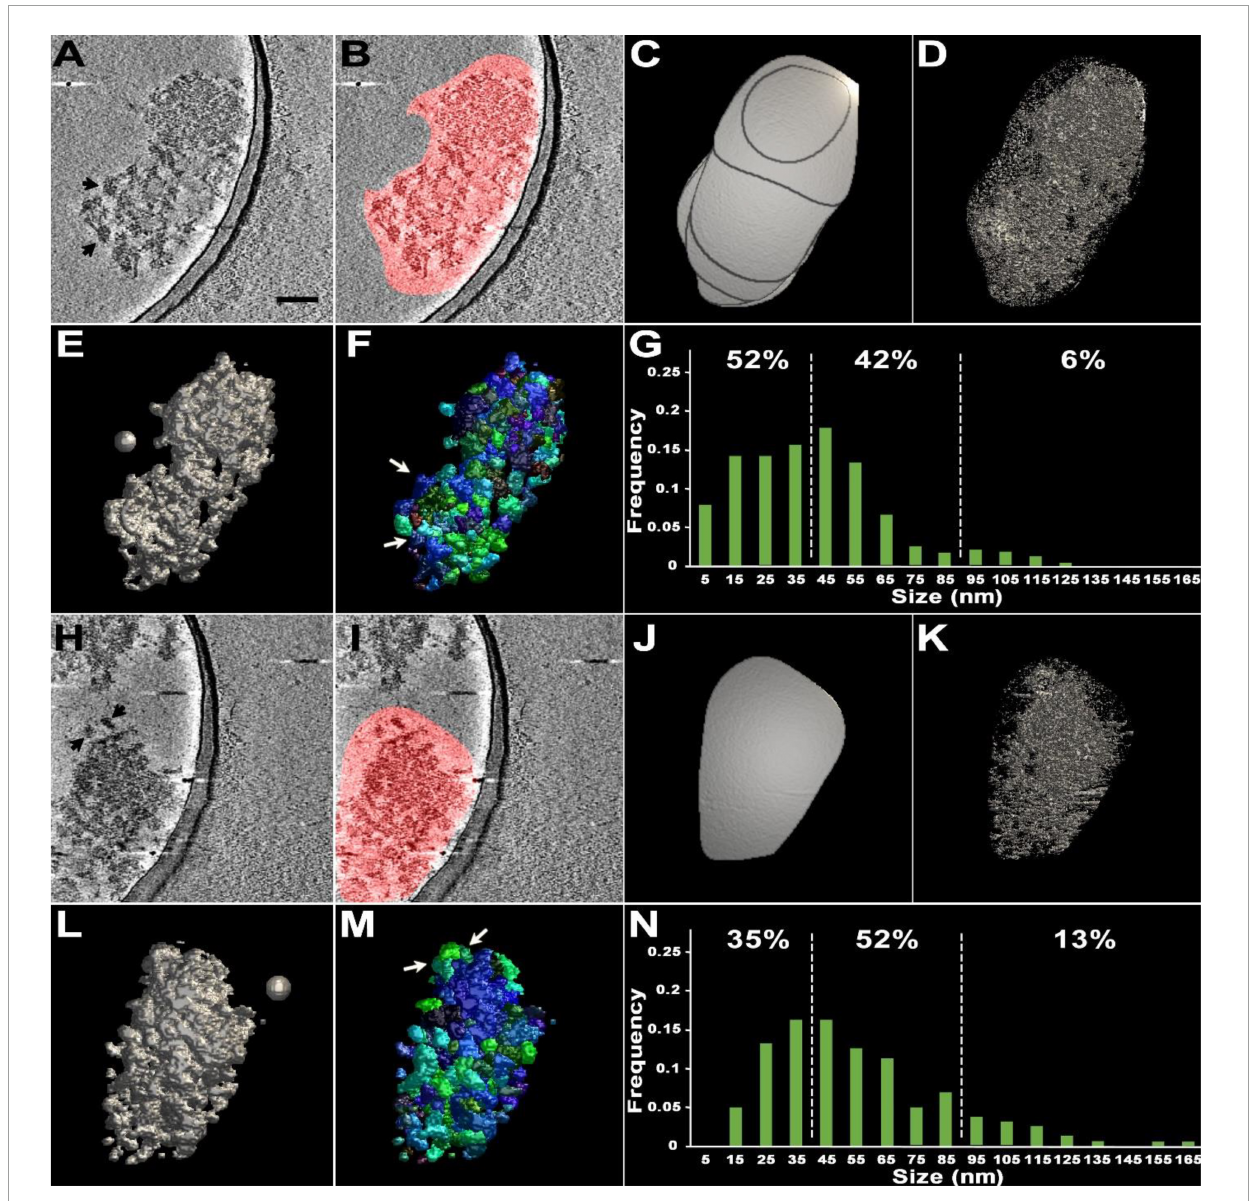
FIGURE2 Cryo-EM tomography and subsequent segmentation of two sonicated PSDs. (A,H) A virtual slice (2.8 nm thick) of each of two different PSDs through their reconstructed volumes. Black arrows point to clearly delineated structures within the PSDs likely to be loosened upon sonication. Scale bar = 100 nm. (B,I) Virtual slices with regions of interest containing PSDs marked in red on the two-dimensional slices, segmented by hand without any repetitive manual refinement. (C,J) A surface model of the volume of interest (VOI) containing each of the PSDs by manual segmentation. Here, outlines of segmented regions on slices form lateral surface of the VOI; the outlines of the first and last slices form the top and bottom bases of the VOI, showing that modification of the VOI is required to obtain the properly segmented PSD. (D,K) A surface model of each of the segmented PSDs after lowering the isodensity level to reduce noise. Note that the models are still highly noise-embedded. (E,L) A surface model after application of ASOM onto each of the VOIs markedly reducing the noisy structures automatically. Signal-to-noise ratios increased from 0.93 to 1.9 for panel (D) and from 0.10 to 0.51 for panel (K) . (F,M) Surface models of differently color-coded substructures or modules within each of the PSDs, obtained by 3D watershed segmentation. White arrows point to the automatically segmented modular structures corresponding to those visually noted in panels (A,H) by black arrows. (G,N) Histograms showing size distribution of modules within the PSDs. White dotted lines indicate the range from 40 to 90 nm. The spheres of 50 nm in diameter in panels (E,L) were included as a guidance of the